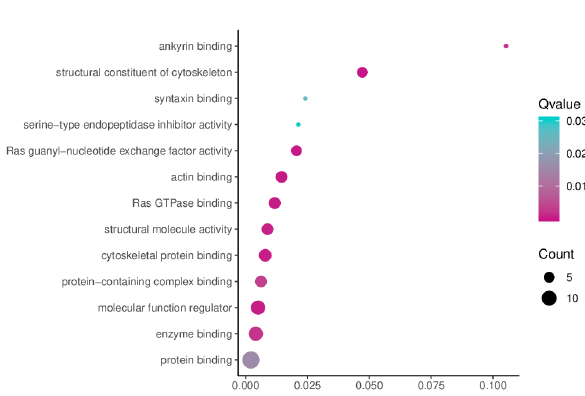
Figure 4: Bubble plot of cellular component enrichment for FOLR1 and relevant genes.